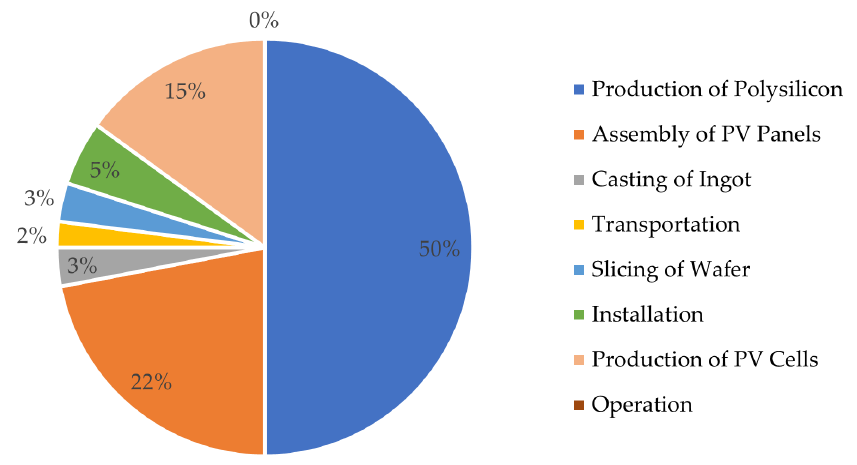
Figure 5. Contribution percentage of each process to the primary energy demand .